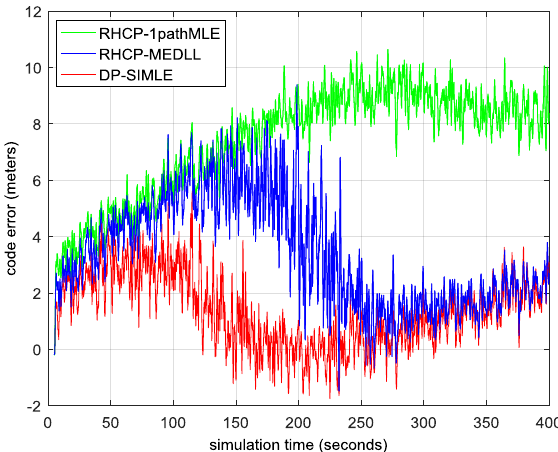
Figure 13. The residual multipath error of different multipath mitigation algorithms in a severe multipath environment with three multipaths.